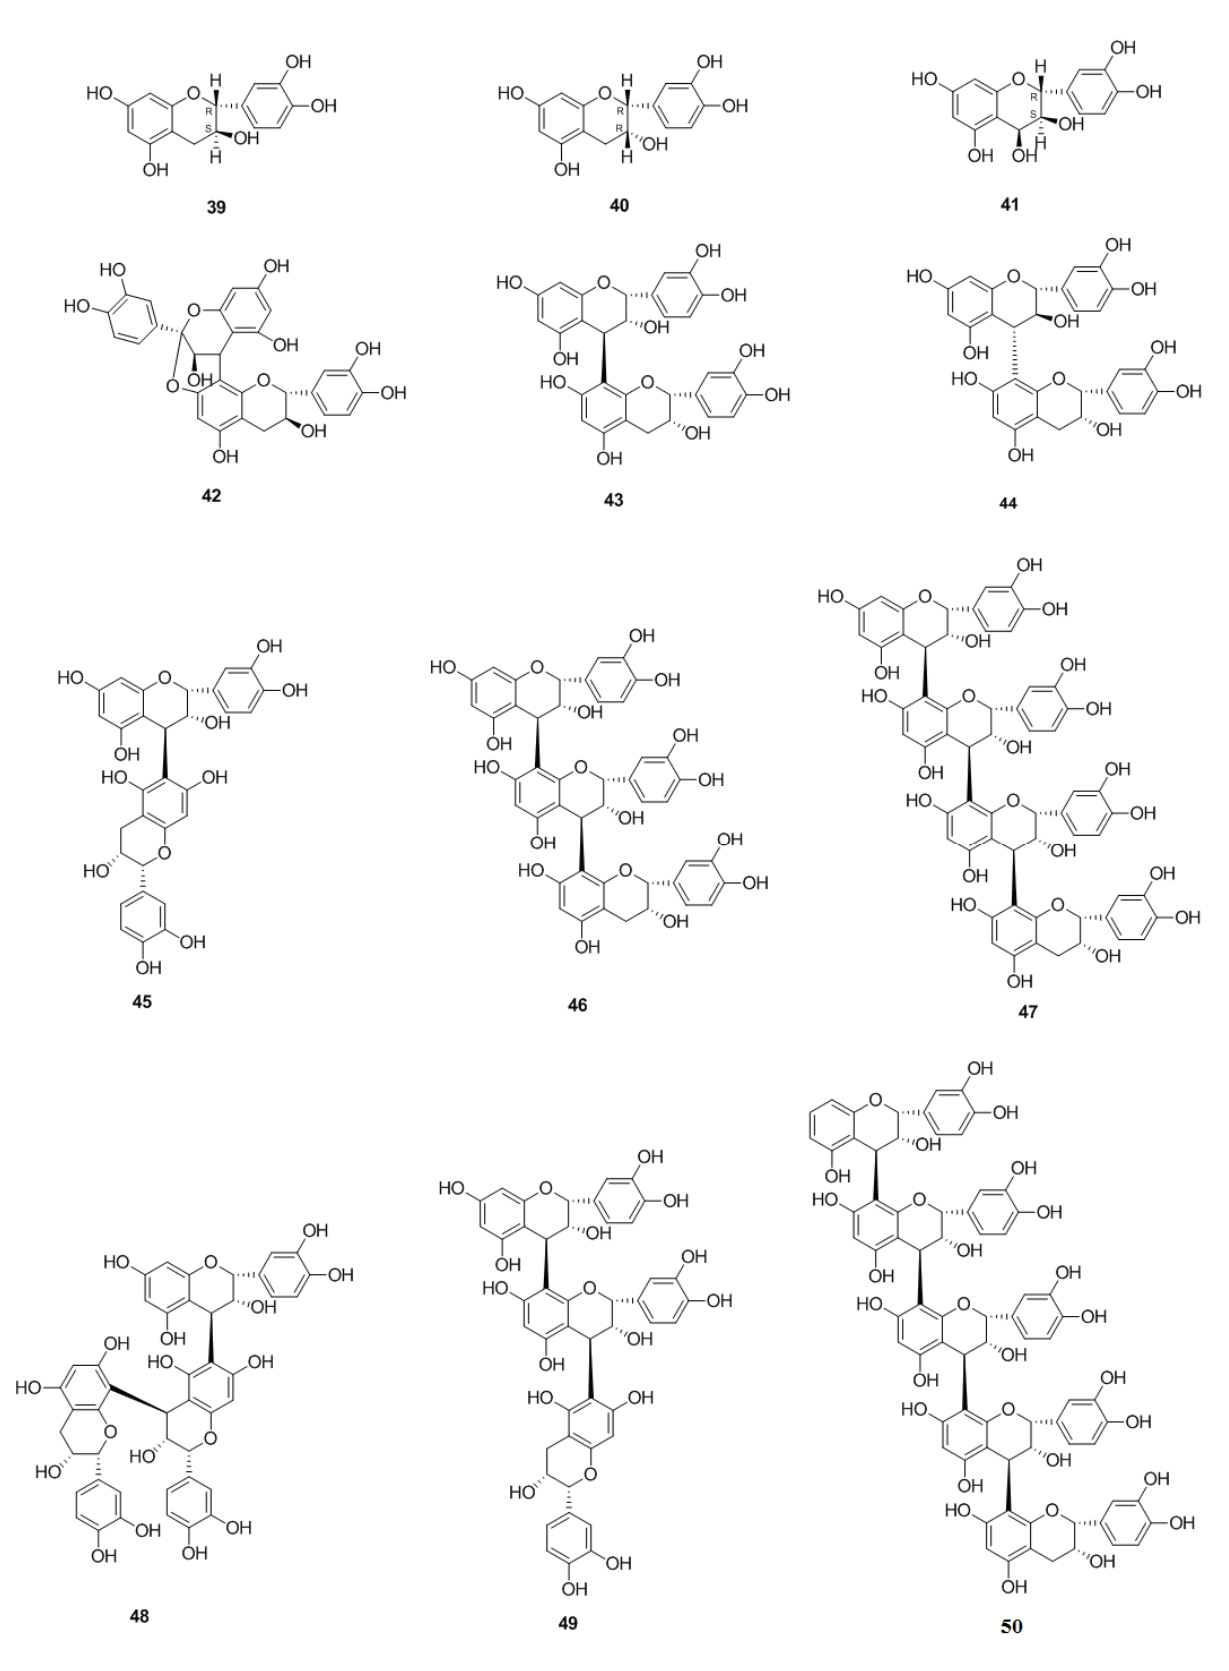
Figure 4. Chemical structures of flavanols and the polymers of flavanols in C. pinnatifida